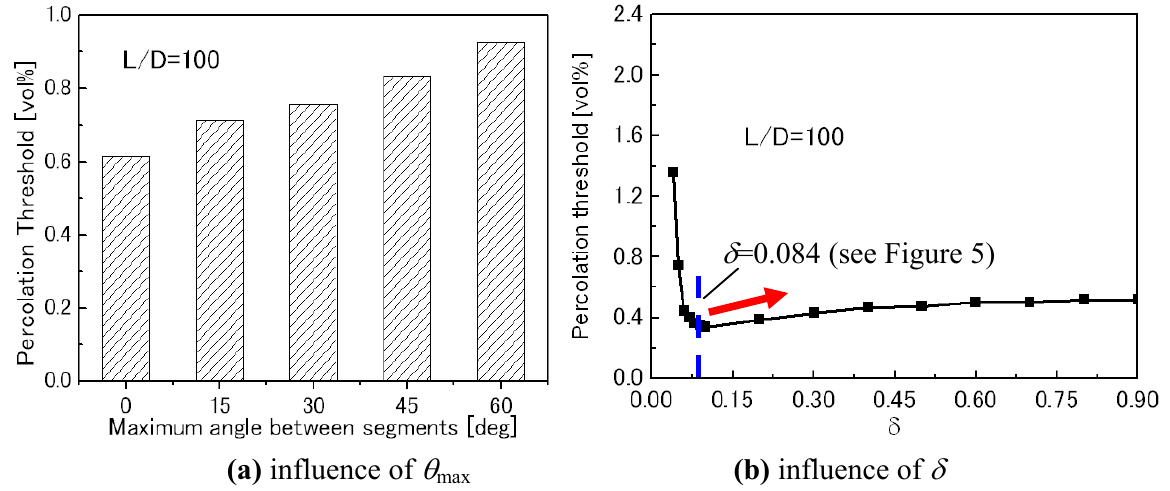
) and aggregate severity (  max